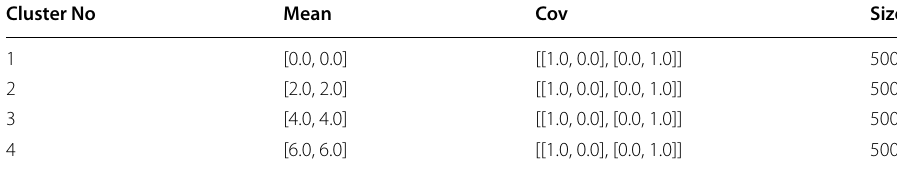
Table 2 The parameters list used for generating multivariate normal dataset Cluster No